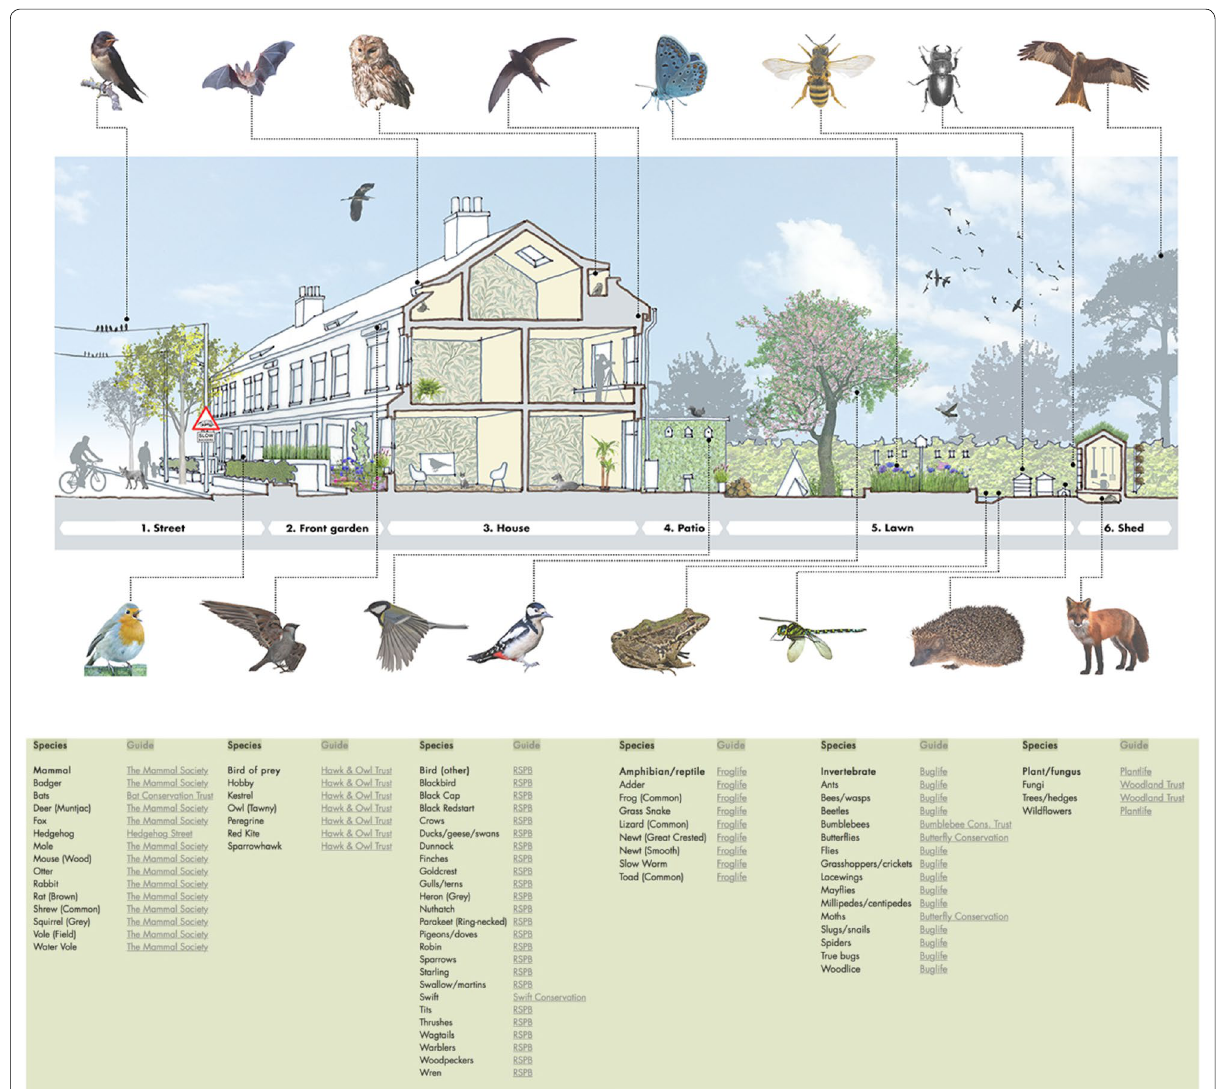
Fig. 1 Sectional perspective showing proposed typical street with adaptations for biodiversity, focusing on species (Siân and Jon Moxon (with altered photos courtesy of Charles J Sharp, Pau.artigas, Super.lukas, Didier Descouens, Ninjatacoshell, George Hodan, Piotr Siedlecki, Peter Mulligan, Potapov